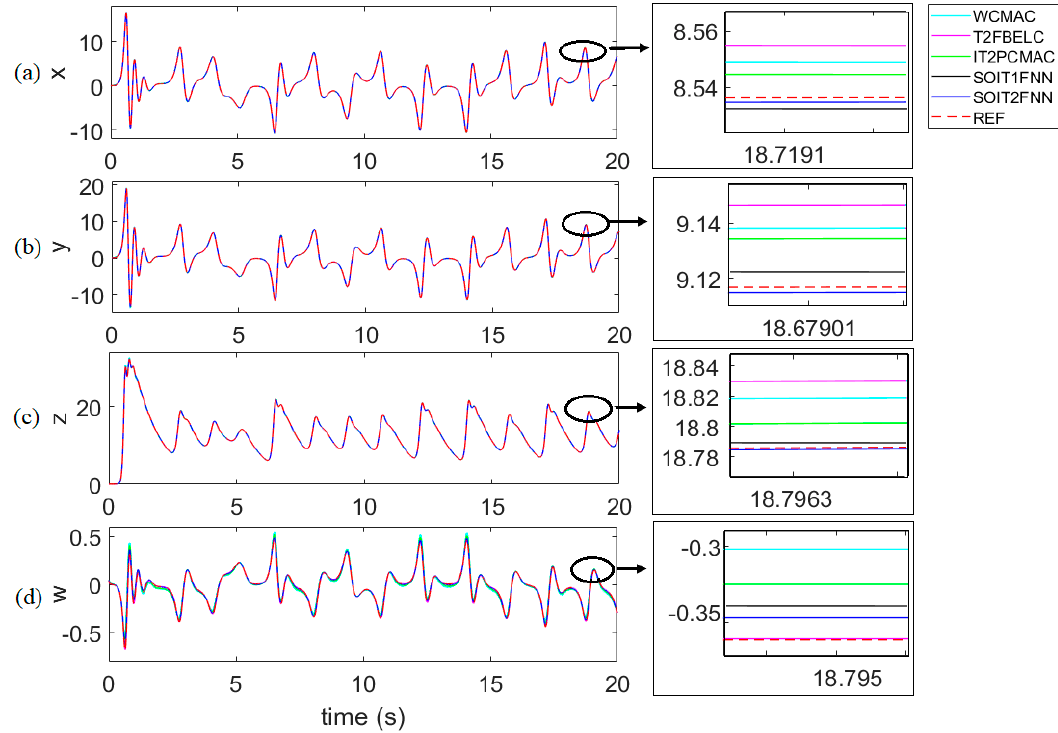
Figure 13. System outputs between the proposed SRIT2PC and other synchronization methods for Case 2: ( a ) x 1 , x 2 , ( b ) y 1 , y 2 , ( c ) z 1 , z 2 , and ( d ) w 1 , w 2